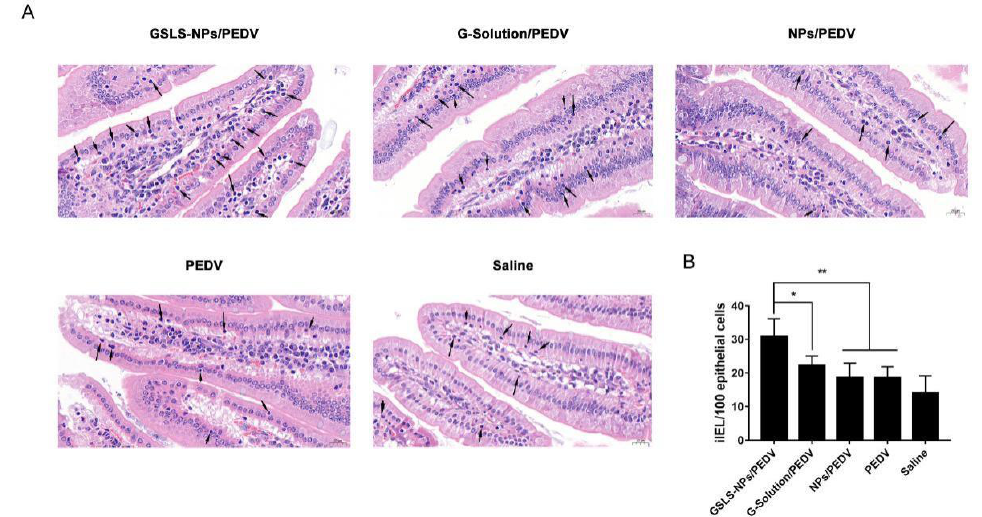
Figure 4. GSLS-NPs increased intestinal intraepithelial lymphocytes (iIELs) in the mucosa of the small intestine. Mice (n = 6) were gavaged daily with saline, empty NPs, G-Solution or GSLS-NPs for 7 days. After the final gavage, the mice were immunized as described above and euthanized on day 35. Non-immunized mice served as the NC. ( A ) Representative images of iIELs in the epithelial cell layer of the small intestine identified by hematoxylin-eosin staining (indicated as arrows). Scale bar = 20 µm. ( B ) iIEL count per 100 epithelial cells in five different fields of intestinal villi on each slide. Data are presented as the mean ± SD. * p < 0.05, ** p < 0.01. Unpaired Student’s t test.